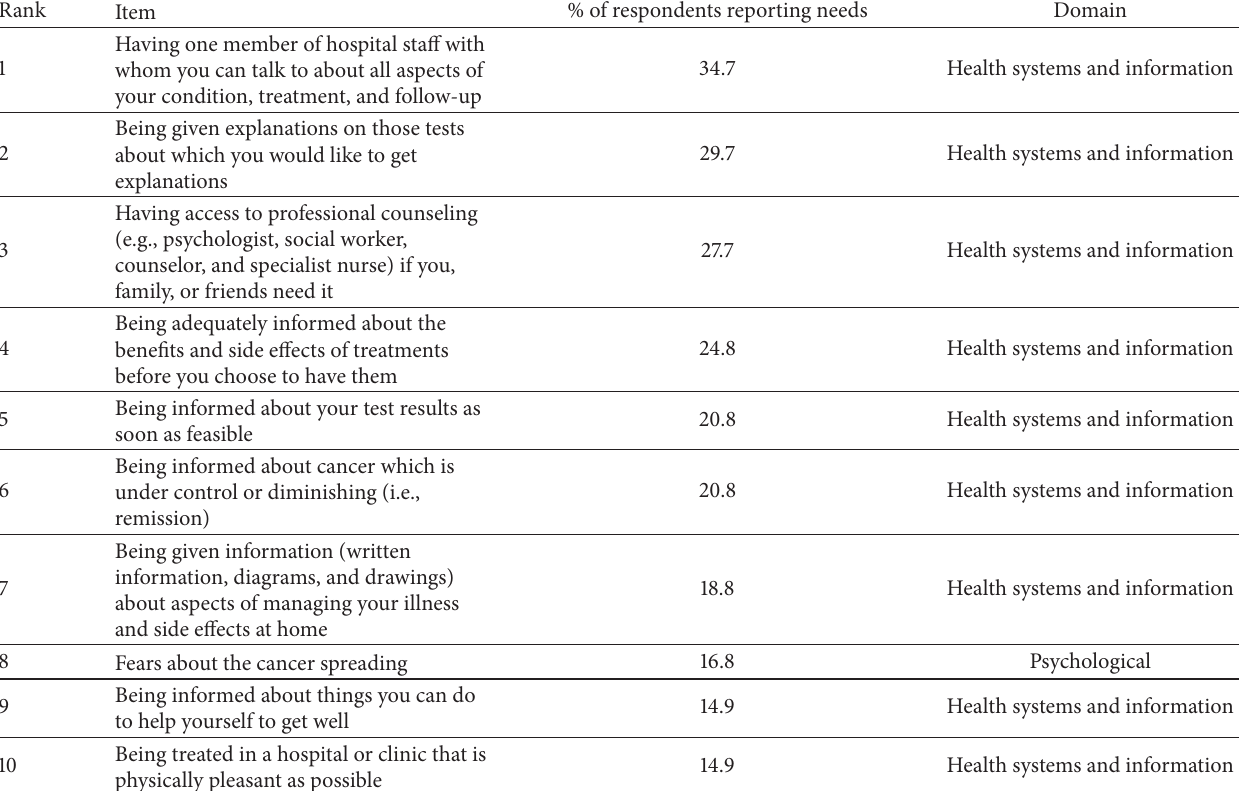
Table 3: Top ten items with highest “moderate to high” unmet needs ( 𝑁 = 101 ).